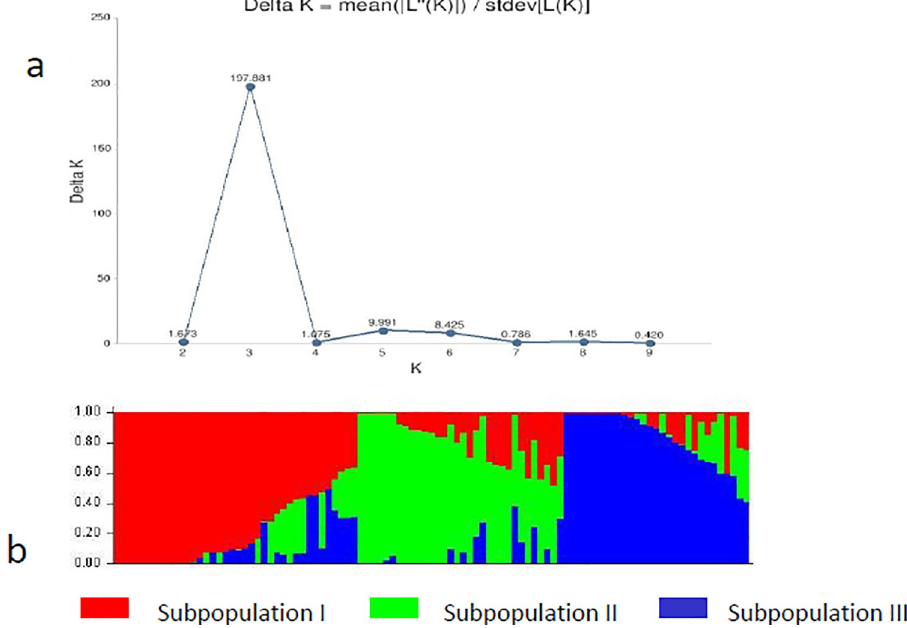
Fig 3. Population structure analysis of 99 groundnut genotypes; (a) Delta K showing the number of populations; (b) Bar plot of population sorted by kinship matrix.